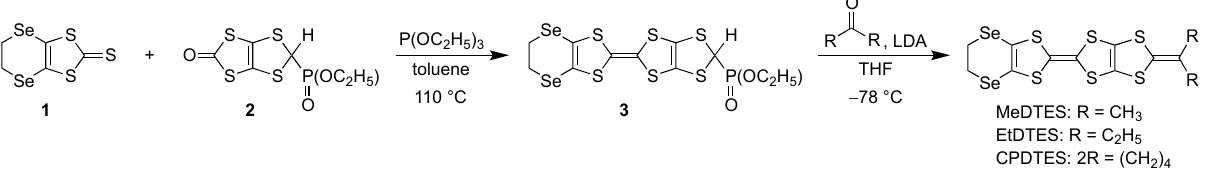
Table 1. Redox potentials a (V vs. Fc/Fc + ) of MeDTES, EtDTES, CPDTES, and related compounds. Donor E MeDTES 0.04 EtDTES